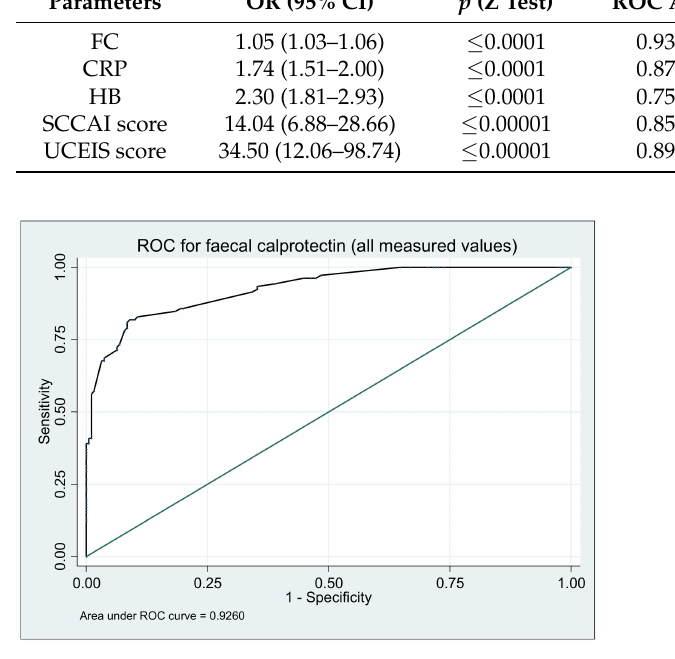
Figure 1. Area under the receiver operating characteristic (ROC) curve to predict ulcerative colitis relapse using fecal calprotectin measurement during 12